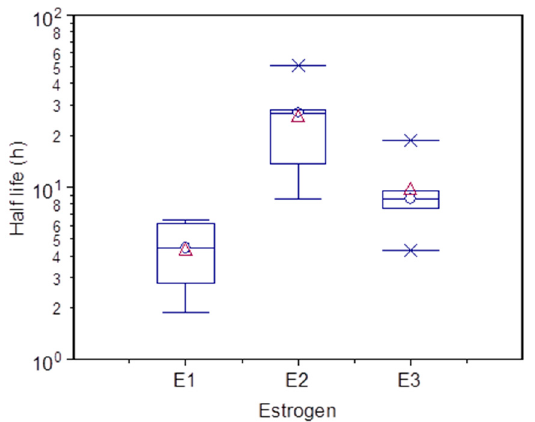
Figure 5. The boxplot of half-life of three free estrogens.